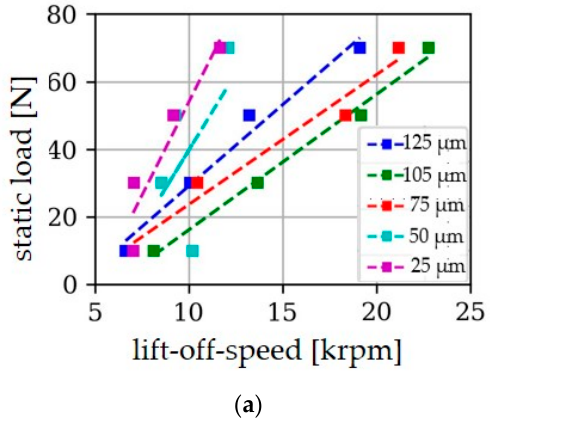
Figure 9. Results of a linear regression for each gap configuration; ( a ) lift-off data and linear regression (blue: 125 µm), (green: 105 µm) (red: 75 µm), (turquoise: 50 µm), (purple: 25 µm), (1 krpm = (100/3)π ⋅ rad/s); ( b ) gradients of the linear regression for each different clearance configuration.